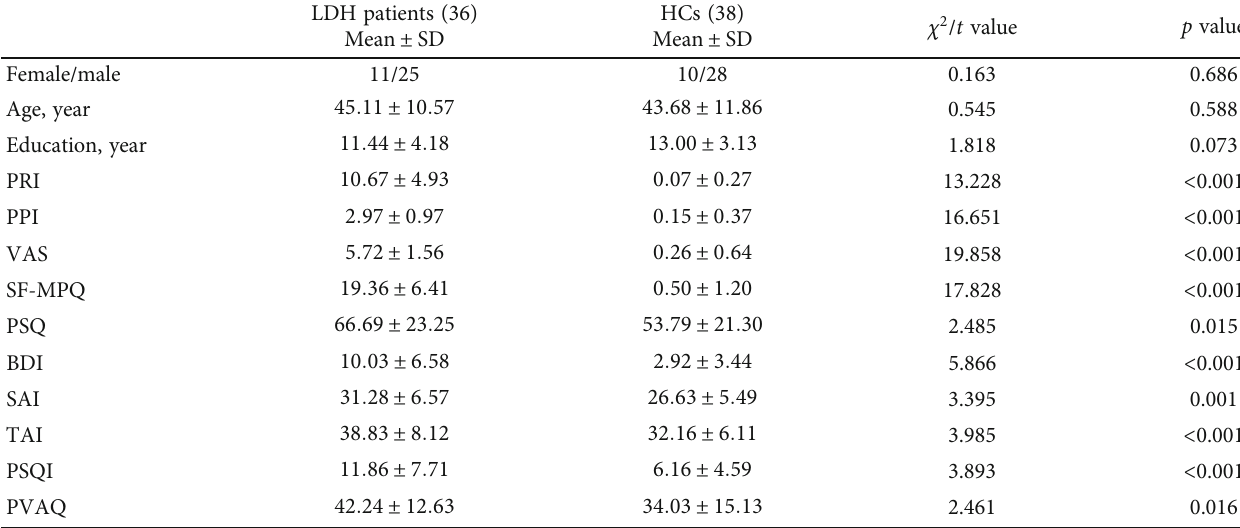
Table 1: Demographic and pain characteristics between LDH patients and HCs ( mean ± SD